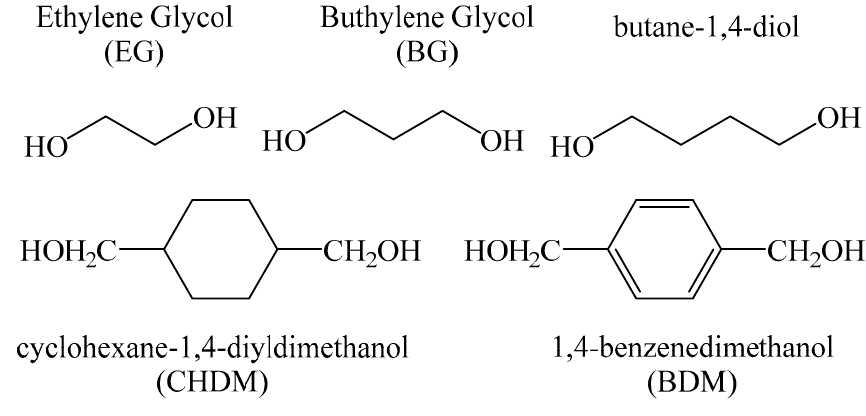
Figure 14. Common diol crosslinkers.